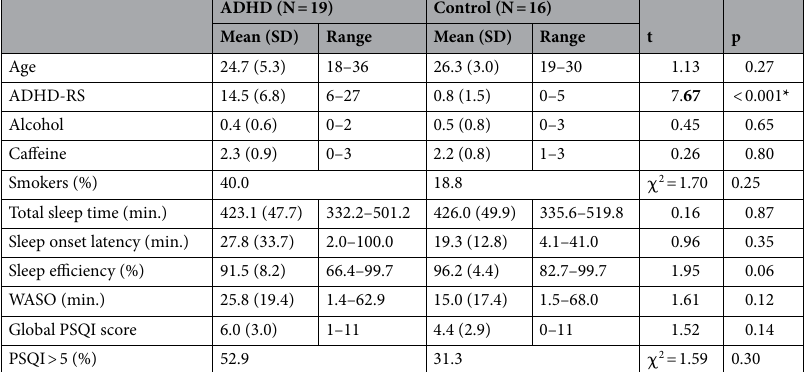
Table 1. Characteristics of the study samples. Demographic characteristics and subjective measures of the participants’ sleep prior to the experimental session. SD Standard deviation, ADHD-RS ADHD Rating Scale, Alcohol number of alcoholic beverages per week, Caffeine number of caffeinated beverages per day, WASO wake after sleep onset, PSQI Pittsburgh Sleep Quality Index. Differences between the groups in the demographic variables and the pre-experimental sleep measures were examined using two-tailed independent- samples t-tests or chi-squared tests. As multiple t-test comparisons were performed, significance (*p < 0.05) was determined following the Bonferroni